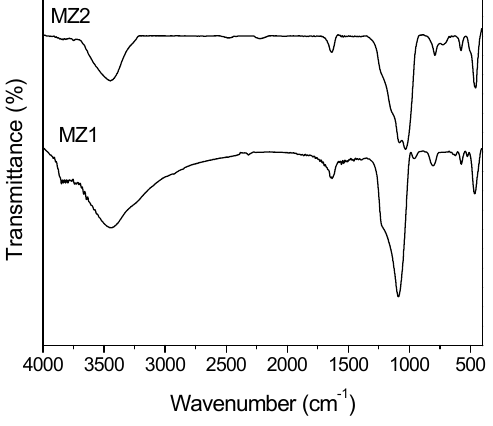
Figure 4. Infrared spectra of MZ1 and MZ2